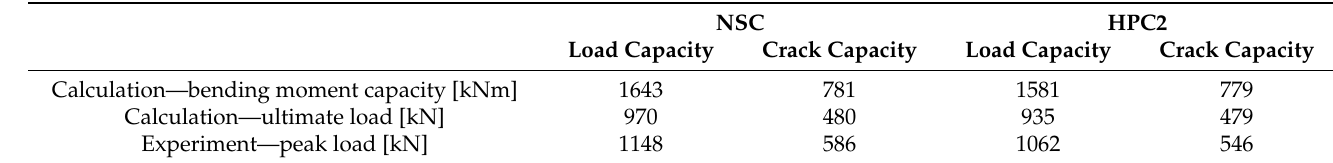
Table 6. Load capacity of specimen beams.